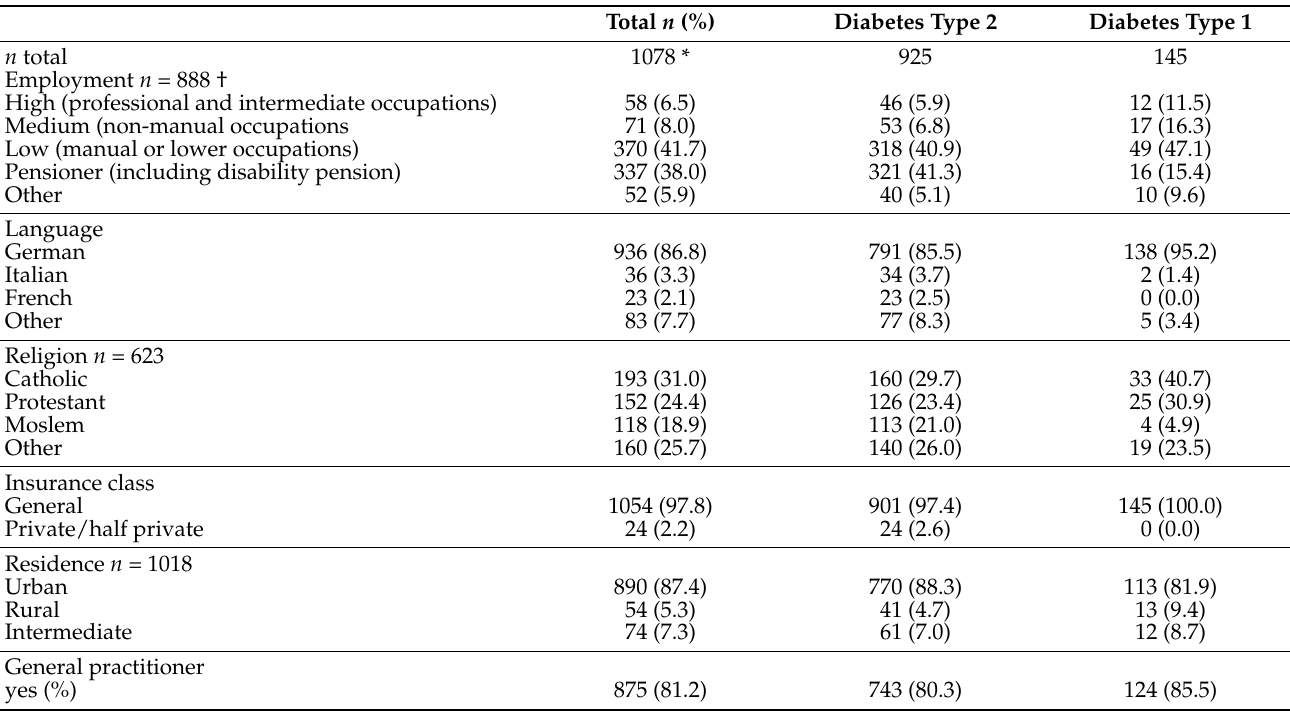
Table 2. Socioeconomic Characteristics of the